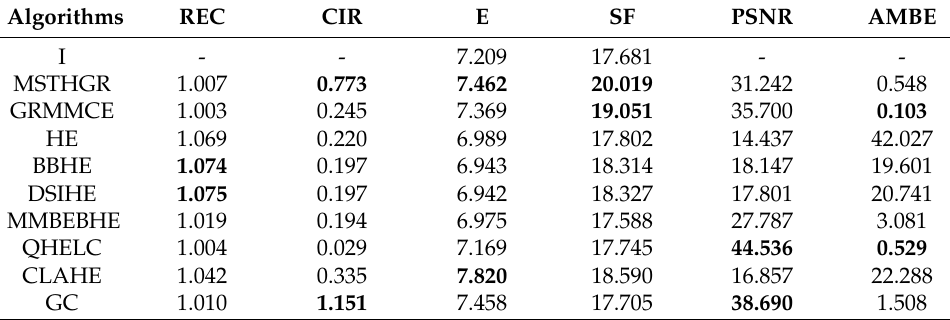
Table 1. Average results obtained by the algorithms.